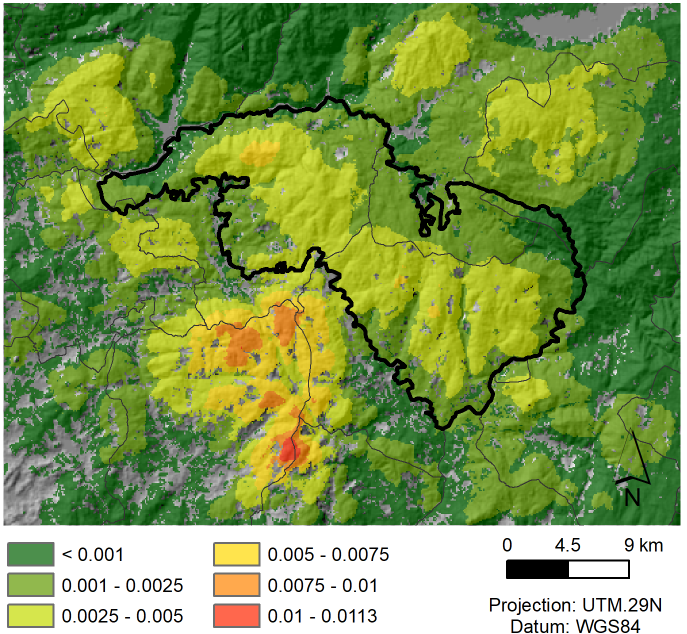
Figure E2. Simulated burn probability (BP) derived from running fire spread simulations using 100000 random ignitions with fire spread durations of 5h (60%), 9h (25%) and 13h (15%). Relative frequencies are shown in parentheses.